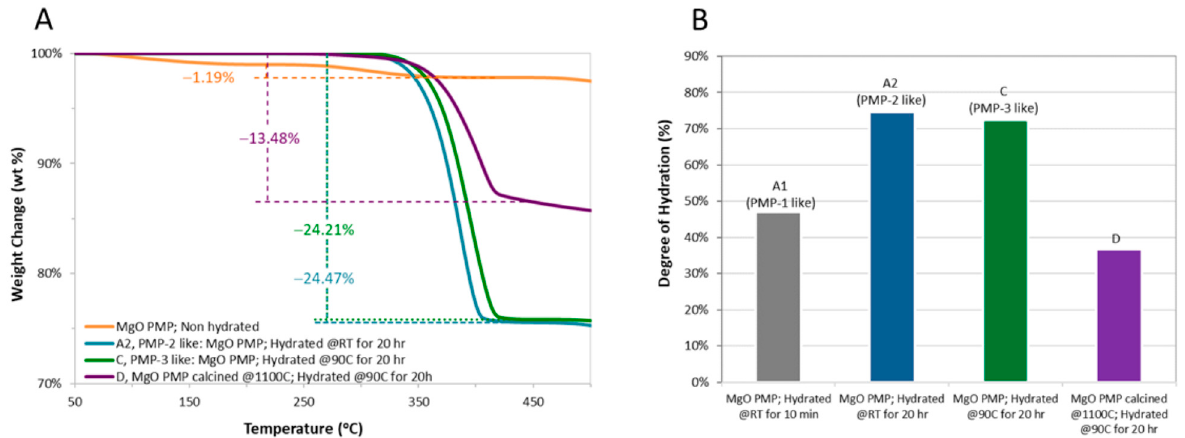
Figure 4. ( A ) Typical weight loss profiles recorded during the TGA of MgO PMP and selected hydrated samples. ( B ) Comparative bar graph, with the Mg(OH) 2 content estimated from the terminal weight loss recorded in the TGA between 200 and 450 °C. Among the depicted samples, A1 is similar to PMP-1, A2 is similar to PMP-2, and C is similar to PMP-3. The sintered sample (D) hydrated very slowly, reaching a hydroxide content of only about 37% after 20 h. This value was well below the ones of PMP-1 and PMP-3.